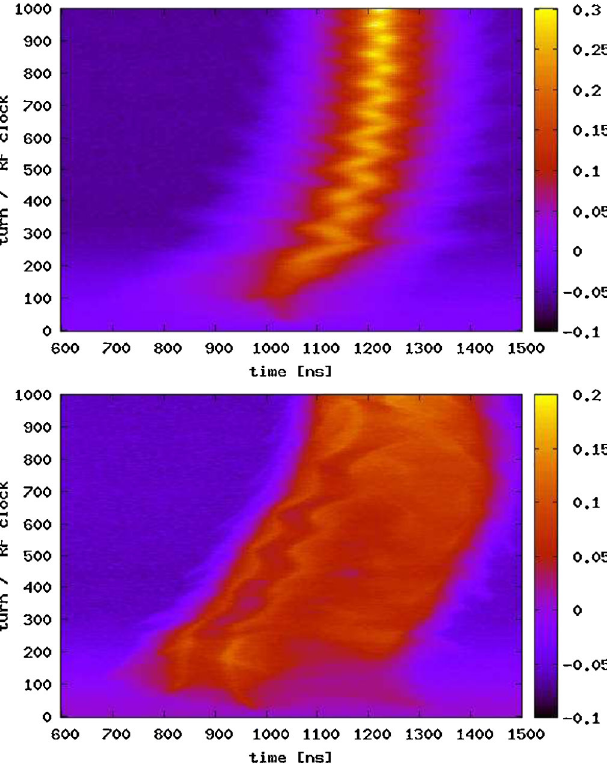
degrees.FIG. 10. (Color) Mountain plots: (upper) fundamental rf only; (lower) with 80% second harmonic, momentum offset of (cid:1) 0 : 2% , and phase sweep of 80